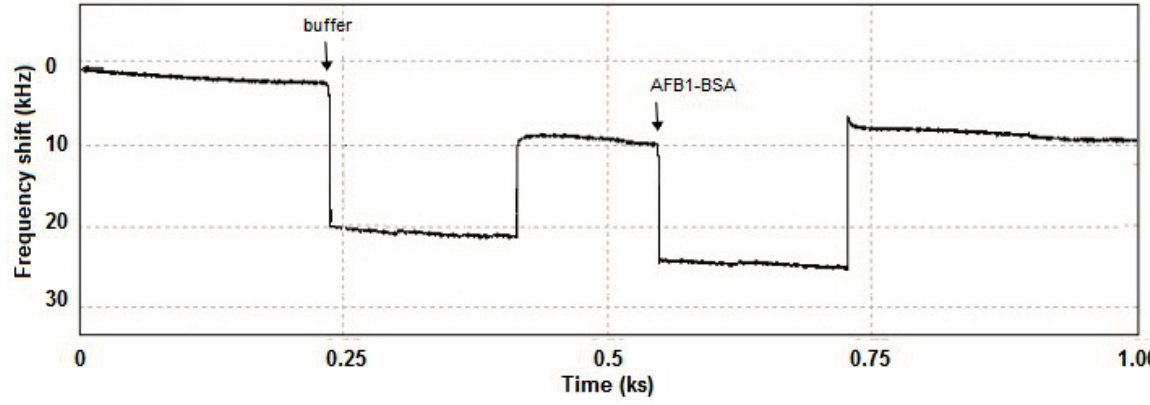
Figure 5. Frequency shifting associated with the amount of the surface-bound AFB1-BSA recorded in PBS solution (pH = 7.5) with the LW-SAW